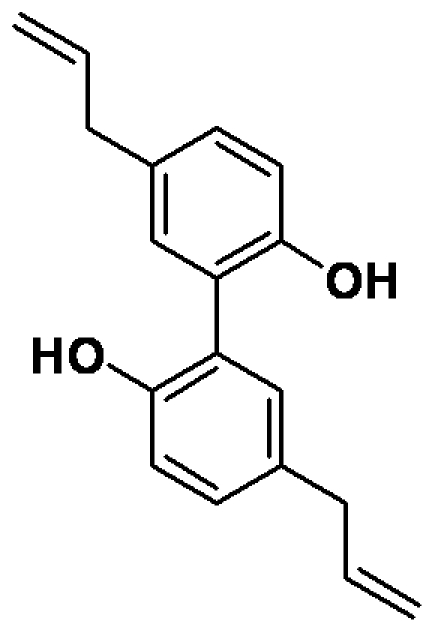
Chemical structure of magnolol.